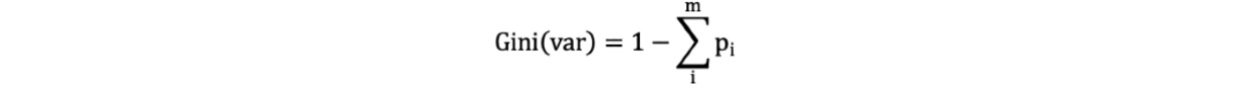
Figure 4. Gini impurity